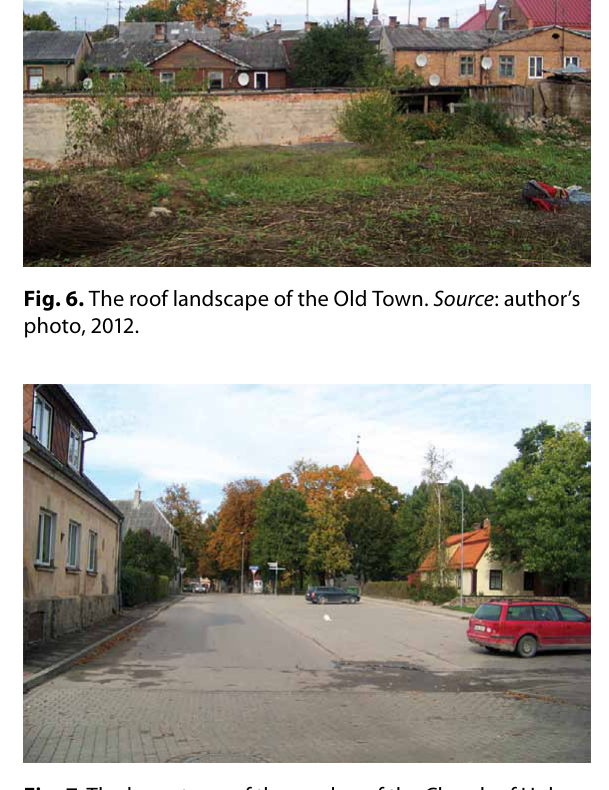
Fig. 7. The huge trees of the garden of the Church of Holy Spirit hide the elegance of the church in the landscape.